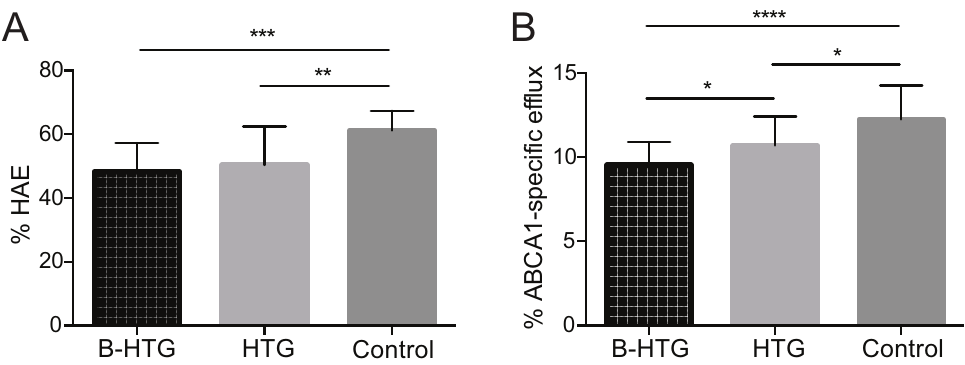
Fig 4. The effect of TG levelson HAE and ABCA-specific CEC. ( A )HAE ( B )ABCA1-specific CEC.MetSyn patientsweredividedinto borderline-highTG (B-HTG, n = 29) andhighTG (HTG, n = 31) groupsandcomparedto eachother andthe controlgroupusingone-wayANOVA withmultiplecomparisons( **** P < 0.0001, *** P < 0.001, ** P < 0.01, * P <